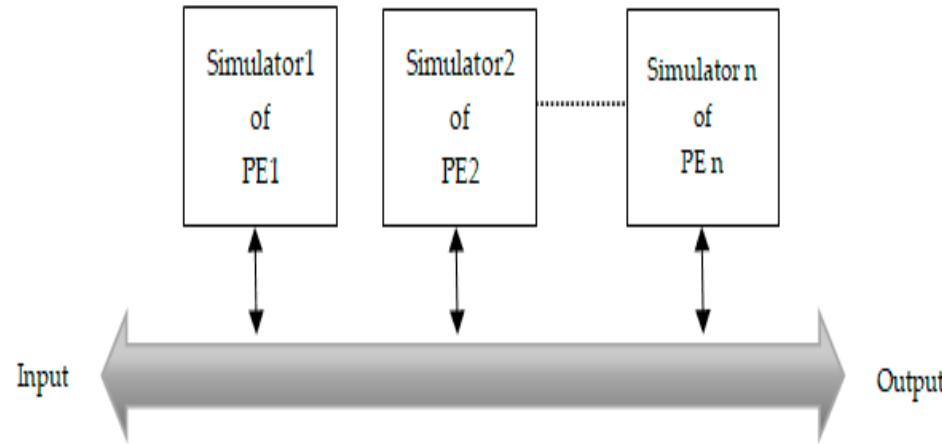
Figure 4. Multiple instances of simulator across PEs.